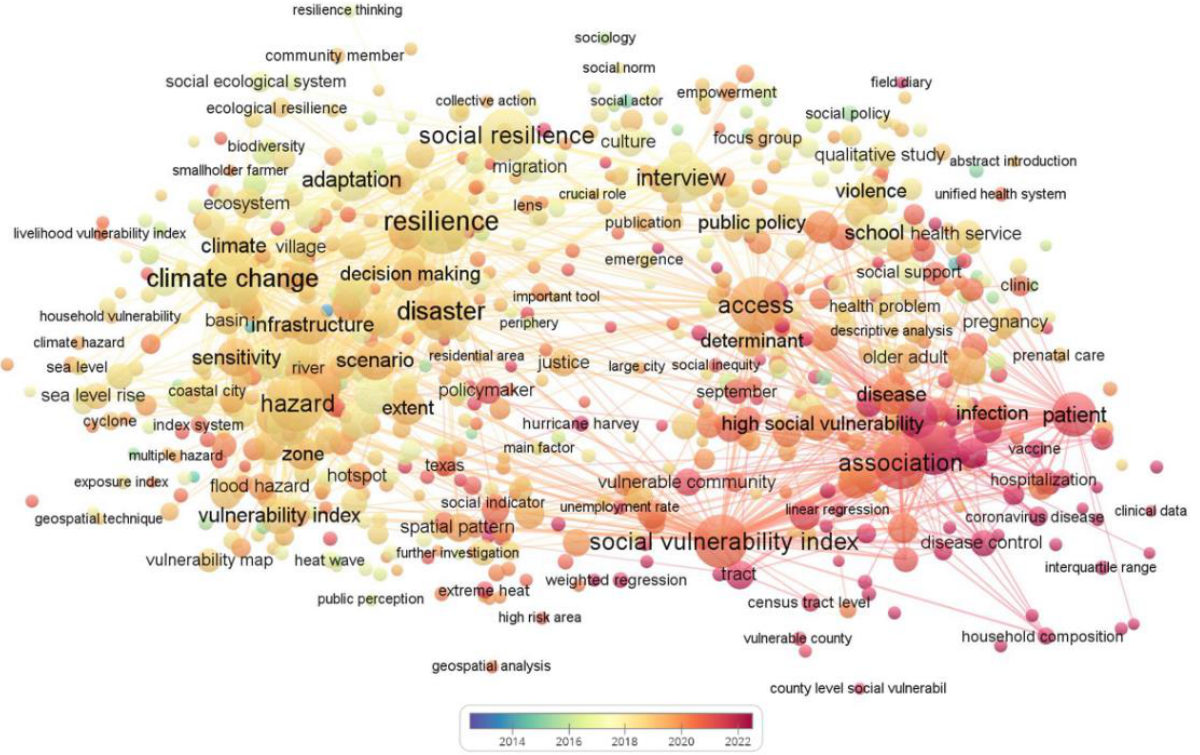
Figure 1. Visualization analysis of social resilience.